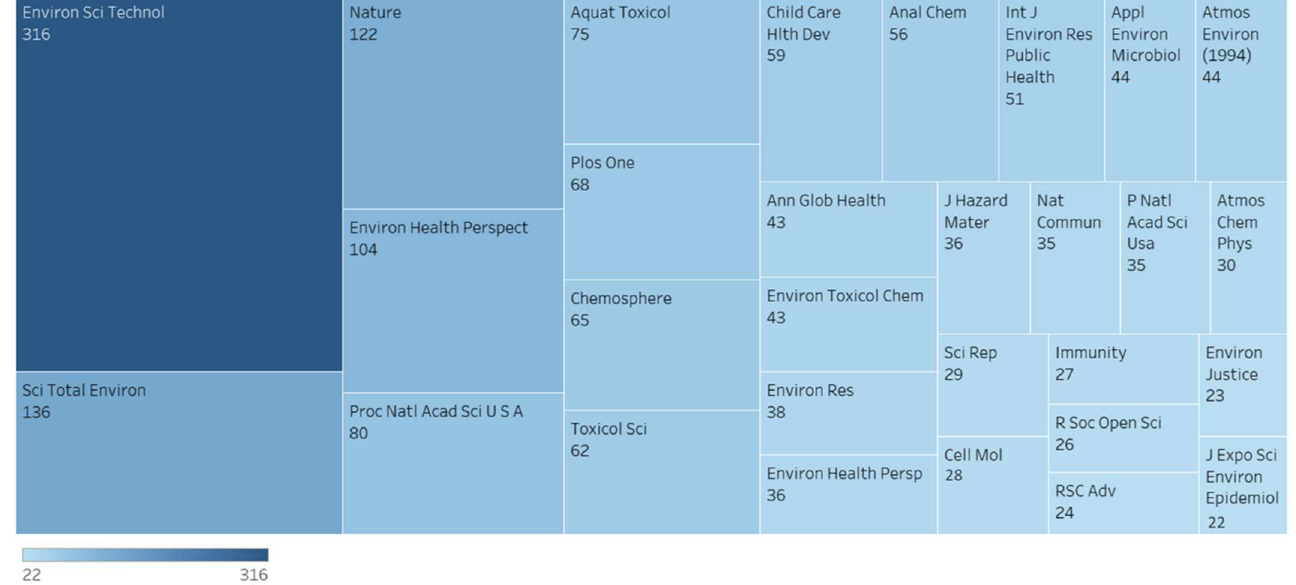
Figure 4. Top journals where SRP grantees have published climate change-related work and number of articles. This image illustrates the breadth and diversity of SRP grantee research within this area, including toxicology, epidemiology, environmental justice, environmental chemistry, and more.